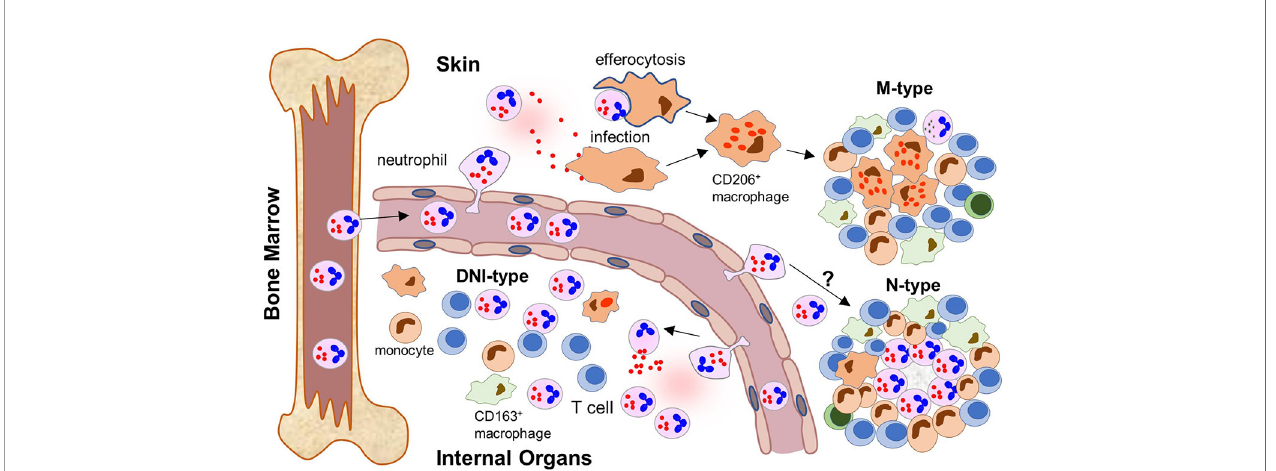
FIGURE 9 | Neutrophil recruitment to in fl amed tissues and formation of different patterns of RuV associated in fl ammation (a proposed model). After maturation, RuV infected mature neutrophils leave the bone marrow where RuV subclinically persisted in myeloblasts before weakening of the immune control mechanisms. The circulating neutrophils recognize signs of ongoing in fl ammation and migrate into the tissue. The location of the in fl ammatory signal and microenvironment at the site in fl uence the formation of a particular pattern of RuV-associated granulomas. In skin, tissue macrophages become infected with RuV either by extracellular virions released by neutrophils or after ingesting infected neutrophils. They subsequently differentiate into epithelioid CD206 + macrophages. T cells, which are recruited to the infected tissues but cannot eradicate RuV infection, form a structure of a mature granuloma around the RuV + macrophage core together with migrating monocytes and macrophages. Presence of B lymphocytes and neutrophils in the mature M-type RuV-associated granulomas is negligible. Some individuals develop N-type necrotizing granulomas with RuV neutrophil cores, but the underlying mechanism is unclear. In fl ux of RuV infected neutrophils into in fl amed internal organs and tissues attracts immune cells of the innate and adaptive immunity but does not result in the formation of compact granuloma structures. Instead, diffuse in fl ammation pattern dominated by RuV positive neutrophils intermixed with other immune cells (DNI-type) is